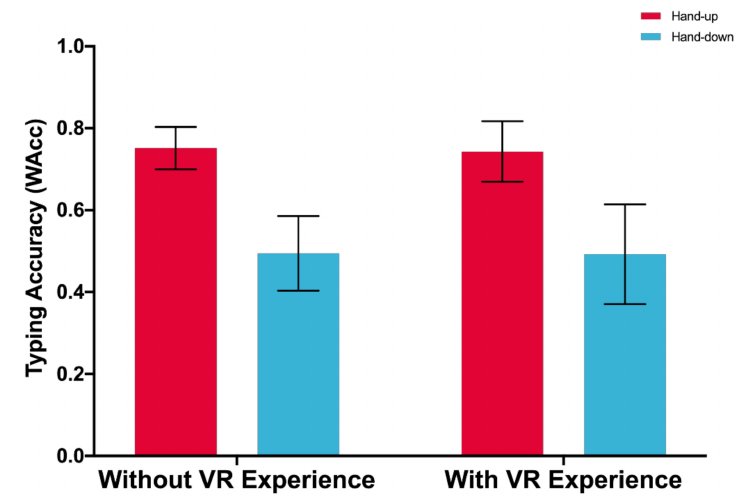
Figure 6. Word accuracy. Error bars represent 95% CI.